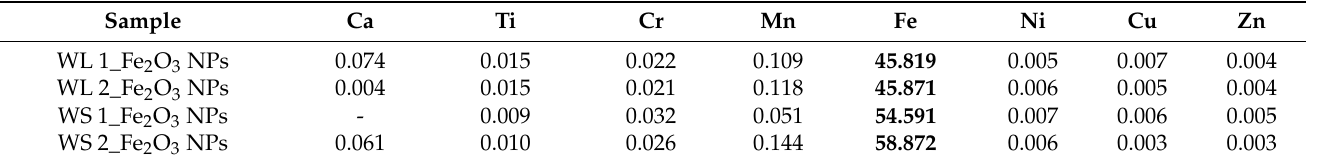
Table 3. Metals composition (ppm) of iron oxide